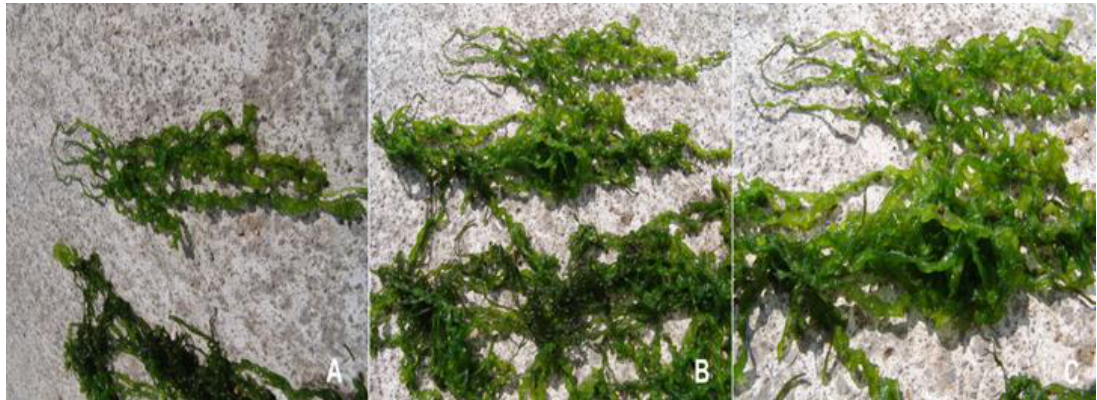
Figure 3. Thalli of Ulva pilifera from the river ( A ), and from the Adriatic Sea ( B , C ). Thallus corrugated, laminar, light green filiform, and intensive ramification.